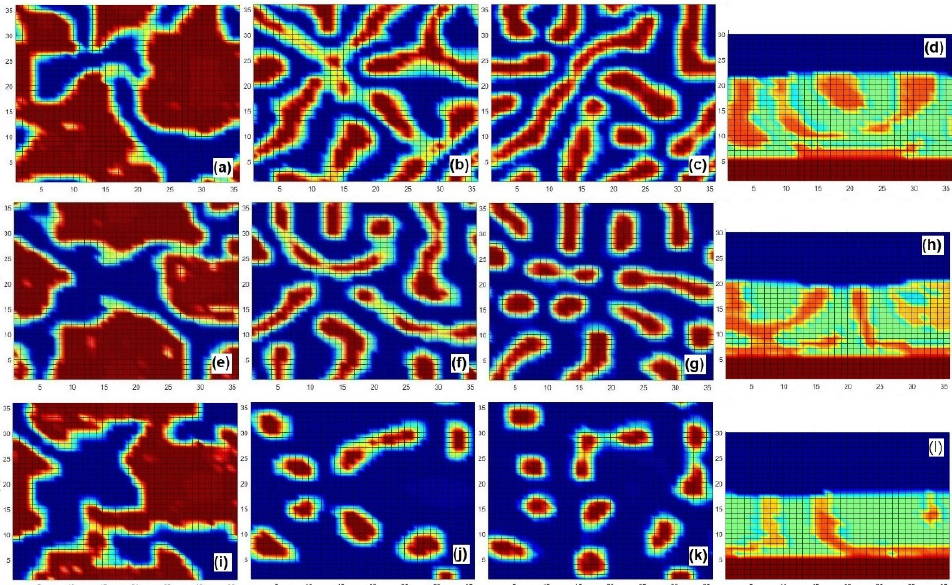
Figure 4. Plot of average lateral grain size near the substrate versus difference k AS − k BS with condition k AS + k BS = 0.9.